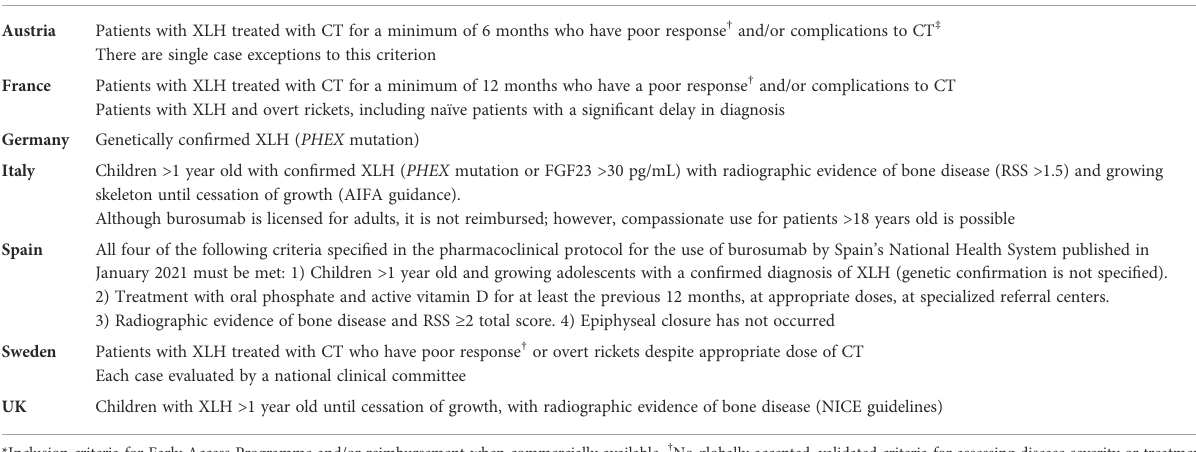
TABLE 2 Criteria for burosumab treatment for children and adolescents with XLH in Europe, as of September 2021. Country Criteria for burosumab